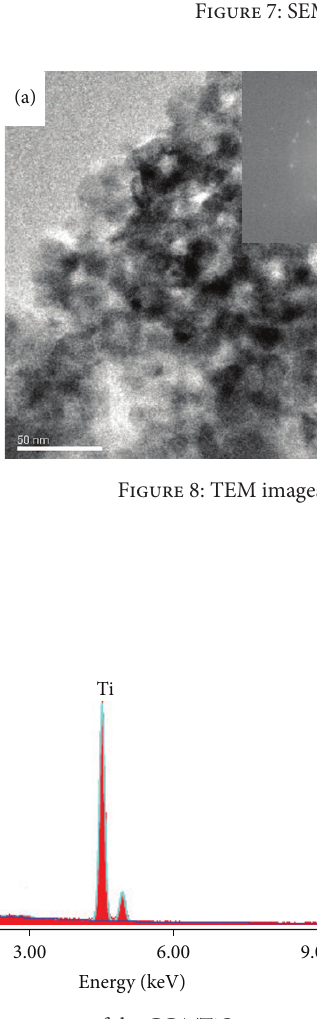
Figure 9: EDS spectrum of the CCA/TiO 2